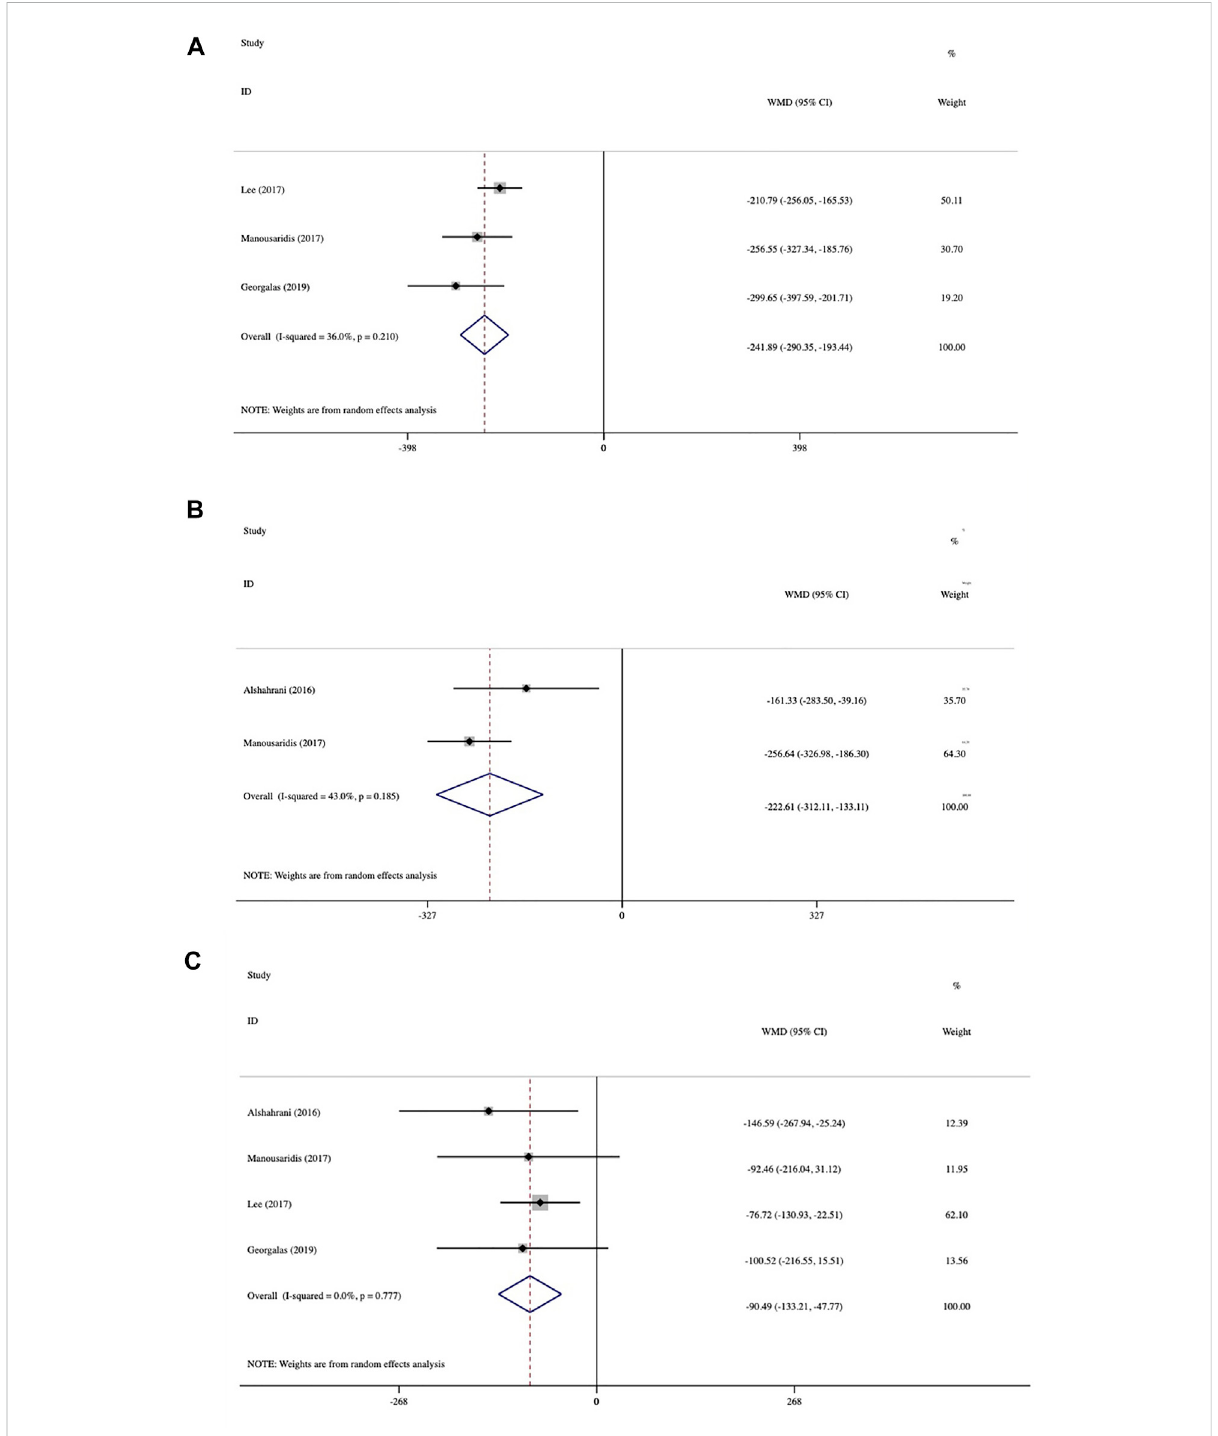
FIGURE 3 Forest plots of mean central macular thickness (CMT) changes at various follow-up endpoints after switching therapy (A) at 2 months, (B) at 3 months, and (C) at 6